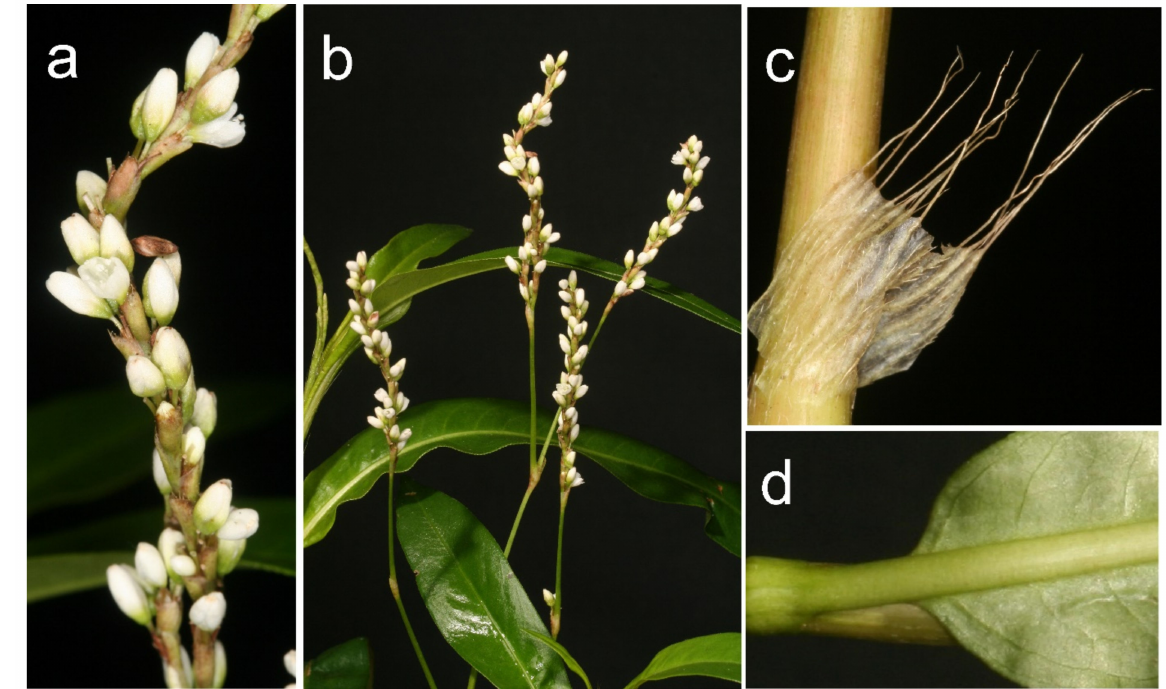
Figure 2. Typical characteristics of Persicaria decipiens are the slender, loose-flowered ( a ), spiciform racemes 2–10 cm long ( b ). the long ocrea bristles ( c ), and the contracted, almost rounded base of the very short petiolated, sometimes almost sessile, glabrous leaves ( d ). Plants from Sevilla (Spain), cultivated ex situ in Germany, October 2012 (Photograph: R.